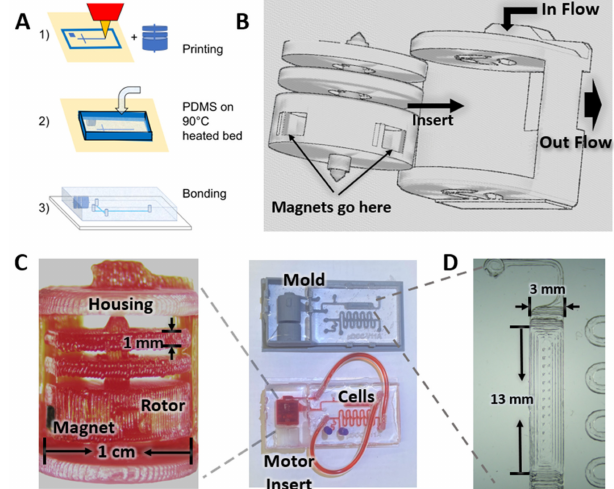
Figure 1. Microfluidic device fabrication method using 3D printing. ( A ) The microfluidics device mold was designed using AutoCAD and then printed using an FDM 3D printer. Microchannels and the µ Tesla pump were printed. The PDMS prepolymer is directly poured onto the heated bed and cured at 90 ◦ C. The device is then bonded with a µ Tesla rotor inside. ( B ) Magnets were inserted in the µ Tesla rotor, the rotor was then assembled in the housing, flow comes from the side of the housing and the rotor rotation drives the flow pumping out of the µ Tesla pump. ( C ) PETG material was used to print the µ Tesla pump, with a rotor diameter of 1 cm. An integrated device was fabricated with µ Tesla pump assembled, with the main channel size being 700 µ m in both width and height, and the smallest channel size being 200 µ m in width and 700 µ m in height. ( D ) Close view of the cell culture and differentiation chamber. The chamber size is 3 mm in width, 3 mm in height and 13 mm in